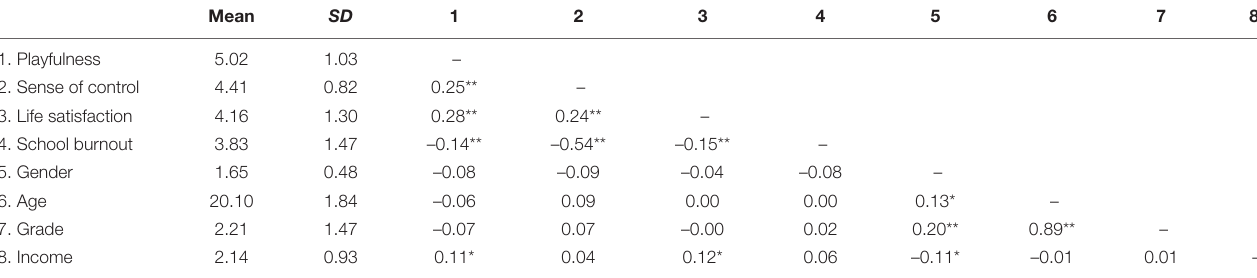
TABLE 1 | Descriptive statistics and correlations of all study